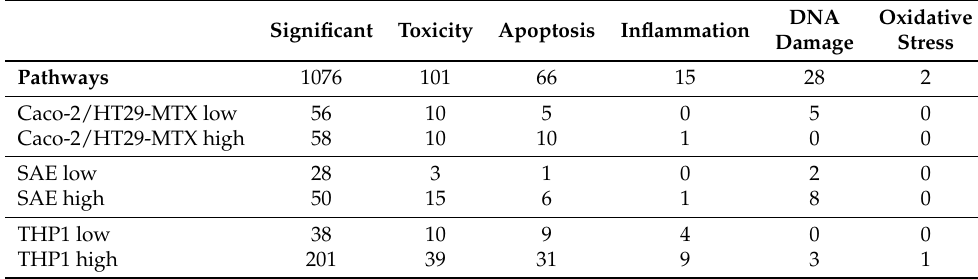
Table 1. Table listing the number of significantly overrepresented pathways, altered toxicity path- ways, and the number of altered toxicity pathways for each GO-term. Significant Toxicity Inflammation